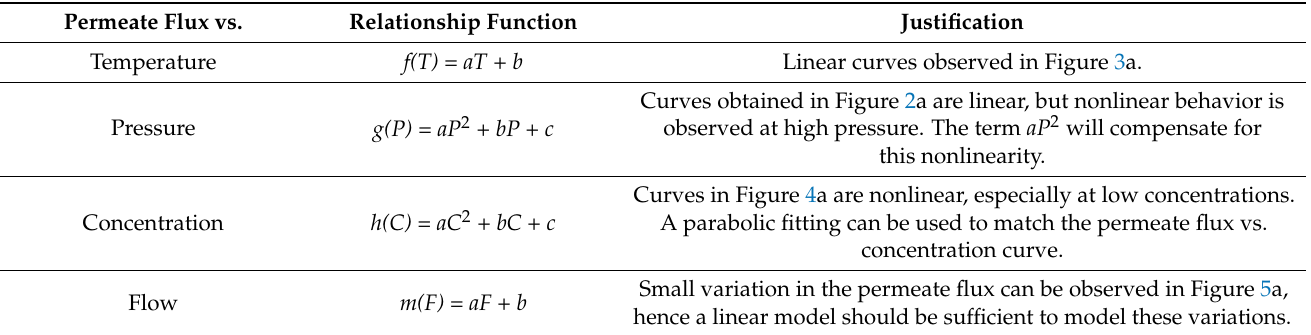
Table 3. Relationship function between permeate flux and the